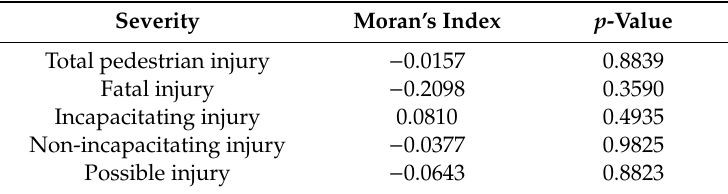
Table 2. Spatial autocorrelation analysis.